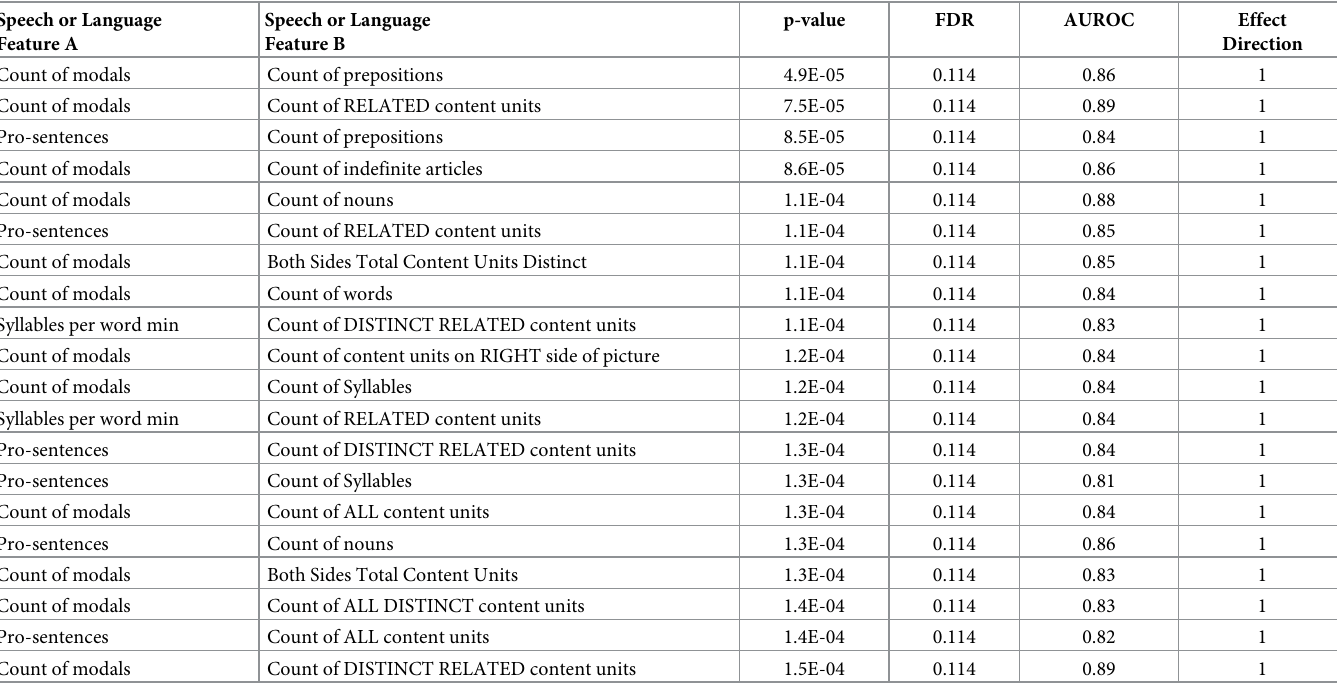
Table 3. Association with membership in the aMCI or HC cohorts of contrasts (A-B) of normalized values of two speech or language features A and